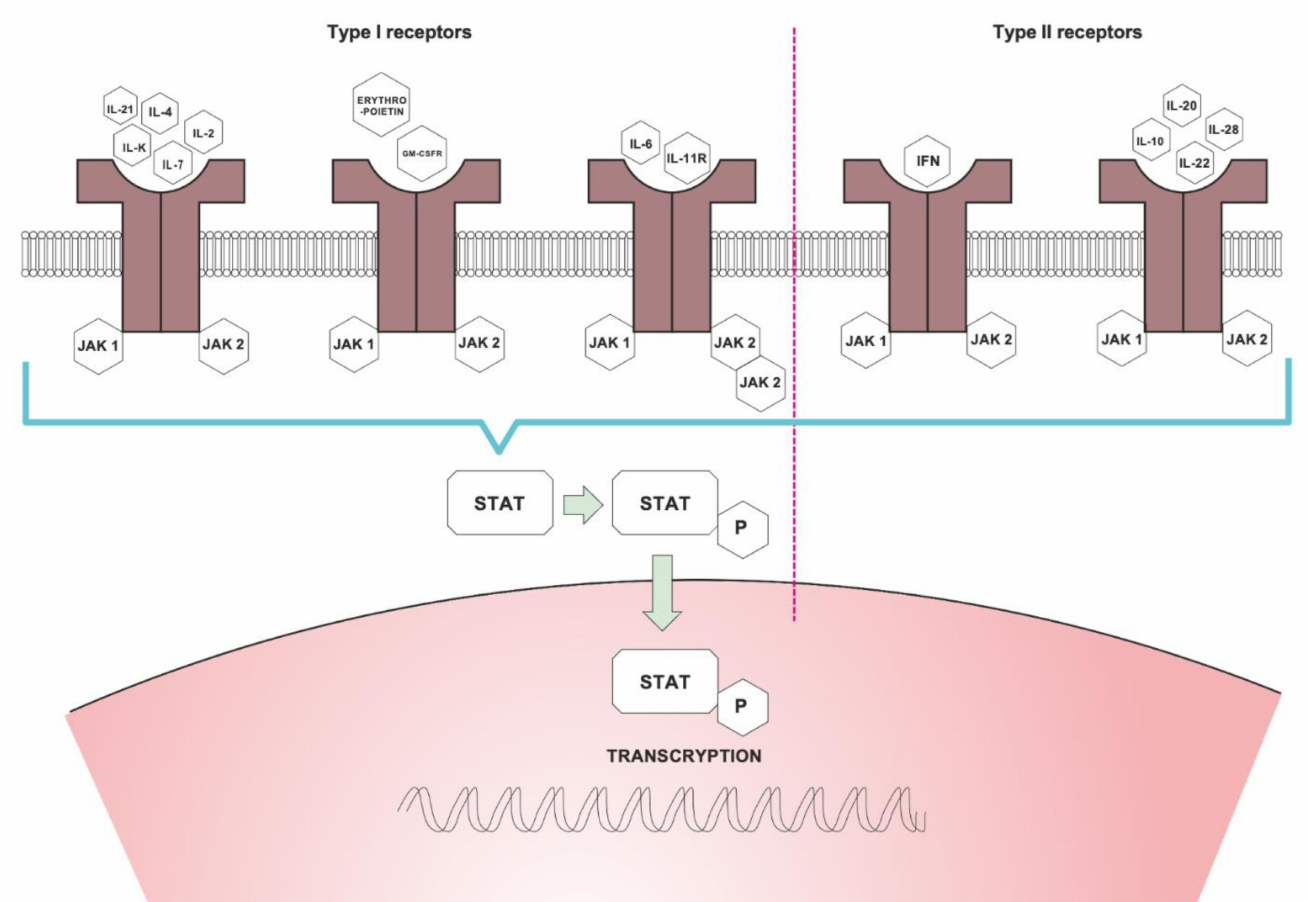
Figure 1. Mechanisms of action of Janus kinases. JAK—Janus kinase, STAT—signal transducer and activator of transcription; P—phosphoric acid, GM-CSF—Granulocyte-macrophage colony-stimulating factor,